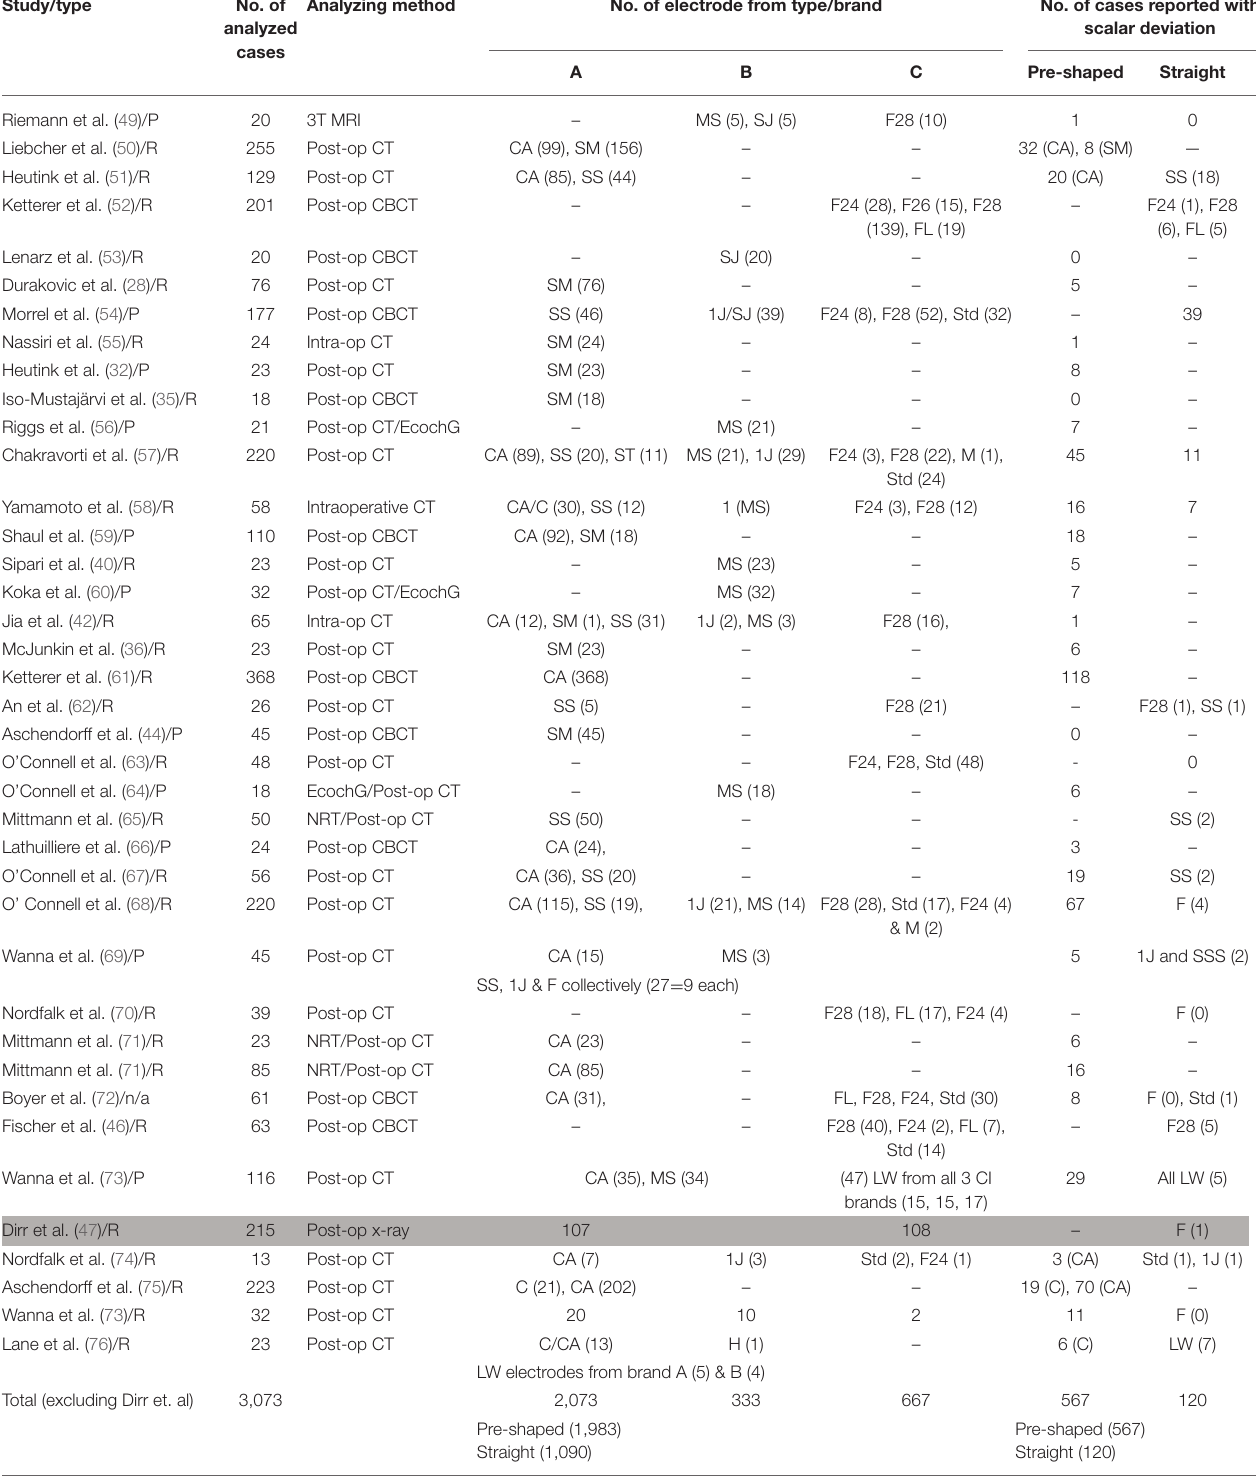
TABLE 3 | Thirty-eight studies reported on electrode scalar